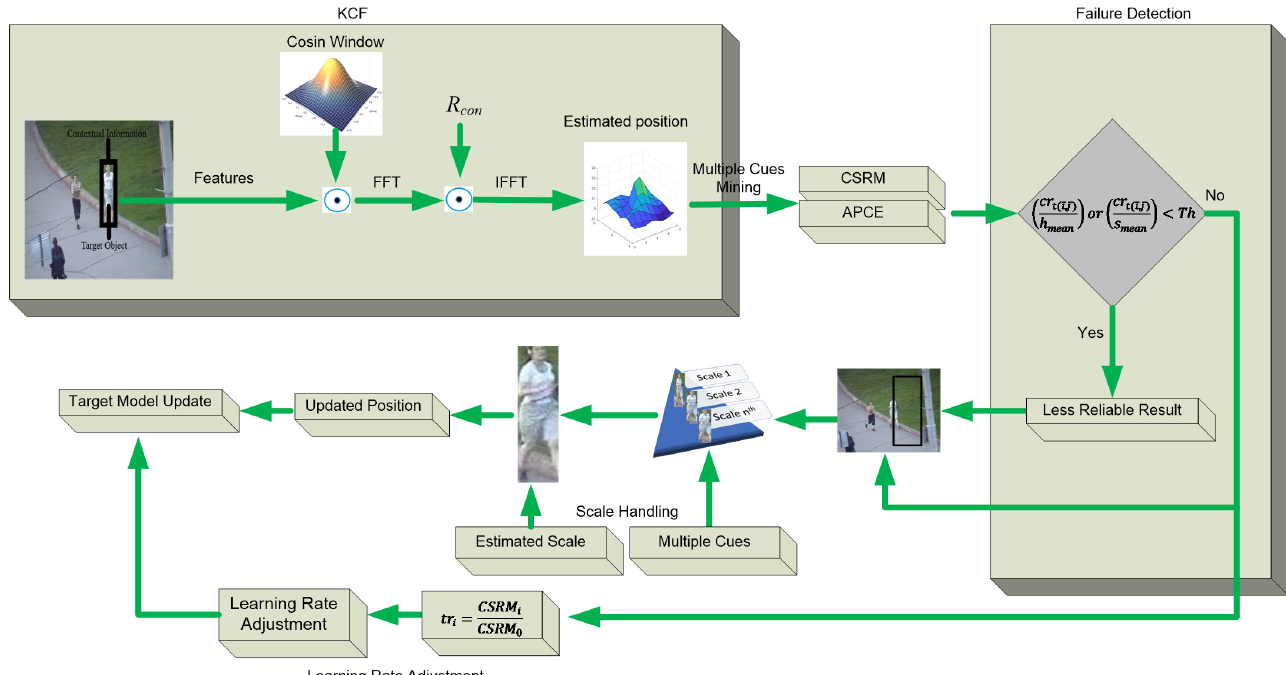
Figure 1. Graphical abstract of proposed tracking scheme. The baseline tracker is shown in the rectangle at the top left corner. The tracking failure detection (in case of occurrence of occlusion or any other issue in a frame) module is shown in the left-most rectangle, whereas the adaptive learning rate strategy is shown at the bottom of the figure. Scale handling mechanism based on multiple cues is shown below the KCF module. Furthermore, multiple cues from the response map are fed the failure detection module, and the learning rate is adjusted accordingly.